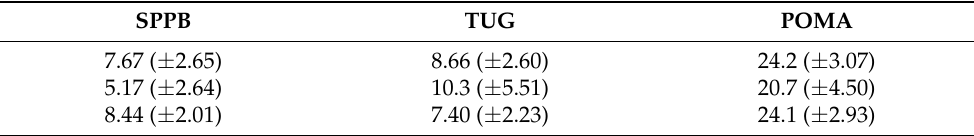
Table 1. The mean pre-test measurements T 0 for the three groups 1